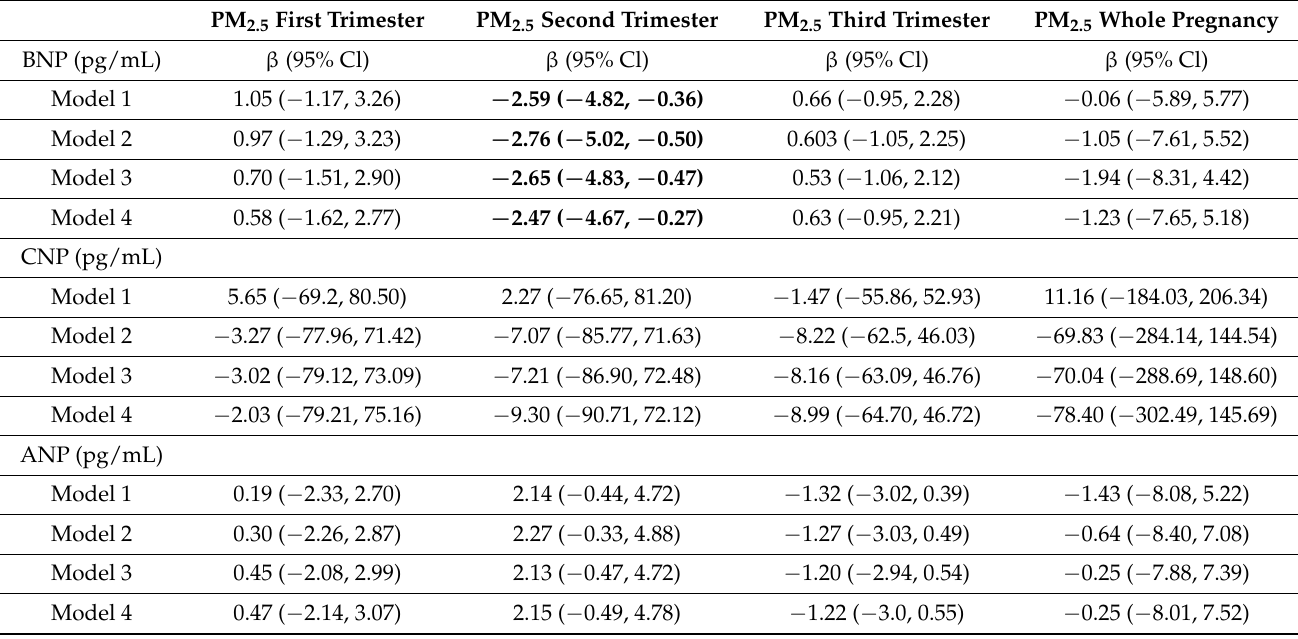
Table 4. Linear regression models to assess associations between PM2.5 exposure and newborns’ natriuretic peptides.